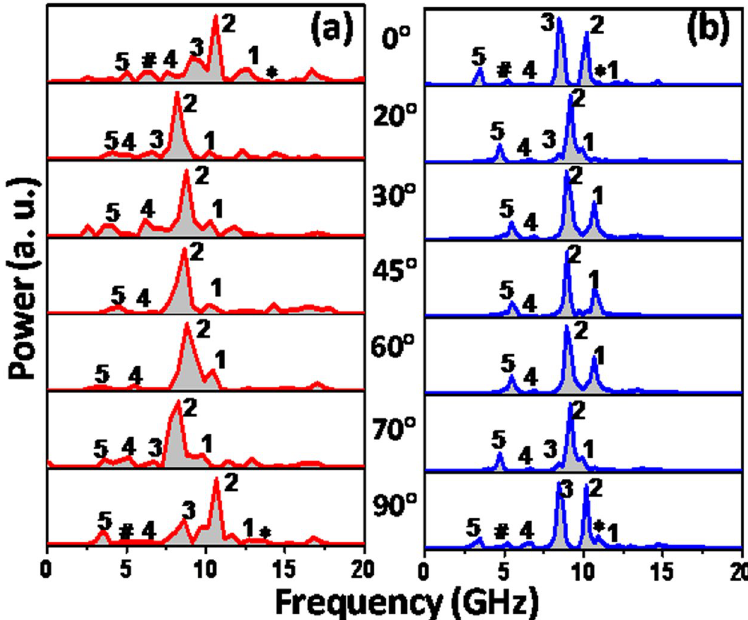
Figure 2. ( a ) Power vs frequency spectra of the sample at those specific orientations of bias magnetic field ( ϕ ) obtained from using ( a ) time-resolved MOKE experiment and ( b ) micromagnetic